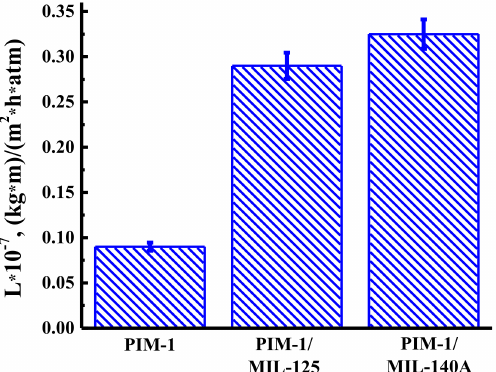
Figure 11. The permeability during nanofiltration of dissolved caramel in the water/ethanol mixture (50/50 vol.%) for nanofiltration PIM-1, PIM-1/MIL-125, and PIM-1/MIL-140A membranes at 50